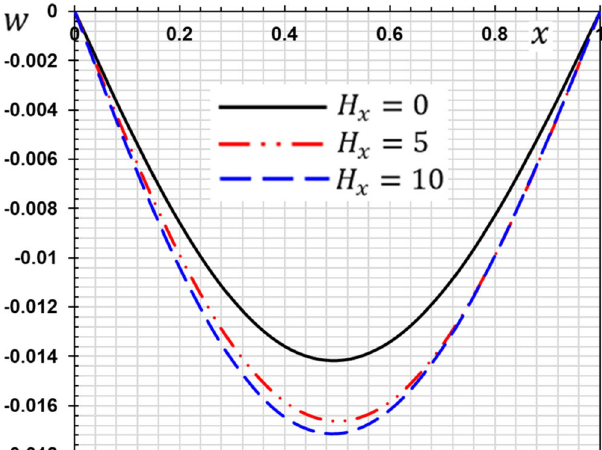
Figure 14. The deflection w with the magnetic field H x .